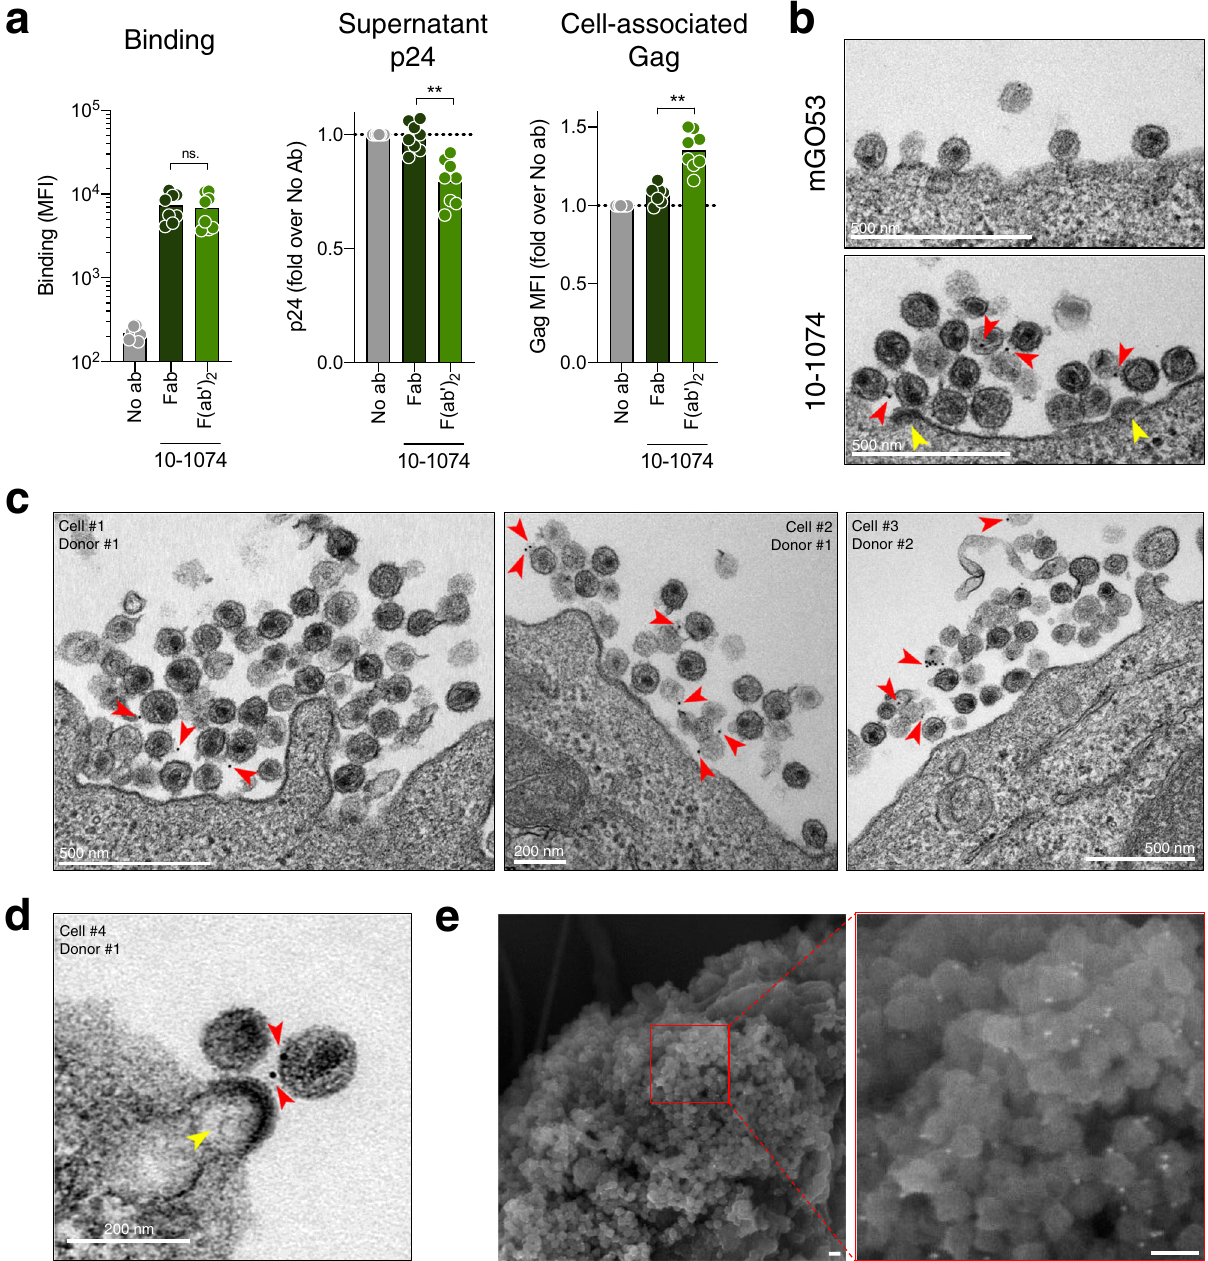
Fig. 3 Tethering of viral particles by bNAbs requires antibody bivalency. a Primary CD4 T cells were infected with HIV-1 (strain CH058) for 48 h and then were cultivated for 24 h with monovalent Fab and bivalent F(ab ’ ) 2 fragments of the bNAb 10 – 1074. Binding of the antibody fragments (left), and fold- change in released p24 (middle) and cell-associated Gag (right) were measured. Each dot represents a donor of CD4 T cells ( n = 8). ** p = 0.0078, ns. not signi fi cant (two-tailed Wilcoxon test). Bars represent the mean. Antibodies were tested at a concentration of 100 nM, b Infected CD4 T cells (CH058) cultivated for 24 h with an isotype control (mGO53) or with a bNAb (10 – 1074) were stained with an anti-human IgG antibody coupled to colloidal gold beads and analyzed by transmission electron microscopy (TEM). Representative images are shown. Red arrowheads point colloidal gold beads, indicative of 10 – 1074. Yellow arrowheads indicate budding viral particles. Scale bar: 500 nm. One representative experiment (out of two) is shown. c Other examples of 10 – 1074-induced retention observed with TEM. The cell donor and the cell ID is indicated for each image. Scale bar: 200 or 500 nm. d Example of viral retention at budding site, including a bNAb immunogold staining in between a viral particle and a budding virion. One representative experiment (out of two) is shown. e Infected CD4 T cells (CH058) cultivated for 24 h with a bNAb (10 – 1074) were stained with an anti-human IgG antibody coupled to colloidal gold and analyzed by scanning electron microscopy. A representative image is shown. Bright white dots are the colloidal gold beads, indicative of 10 – 1074. A magni fi cation on an area with strong colloidal gold staining is shown. Scale bar: 100 nm. One representative experiment (out of two) is shown. Source data are provided as a Source Data fi